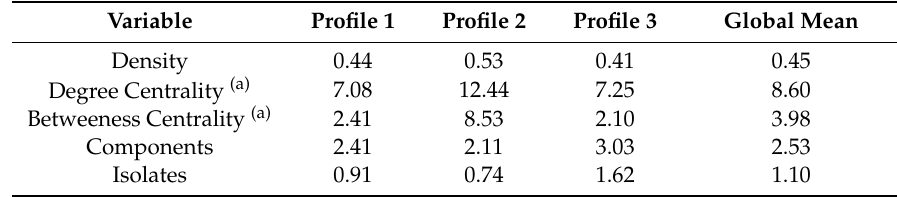
Table 6. Structural variables of the personal network. Profile and global means.